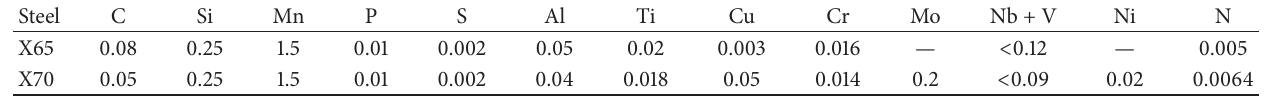
Table 1: Chemical composition of API steel grades X65 and X70.